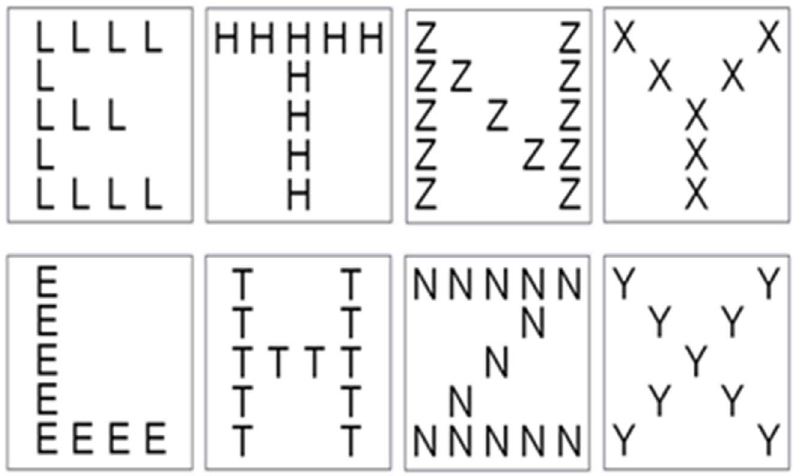
Figure 1. Stimulus examples for global and local target letters E, T, N, and Y with irrelevant letters H, L, X, and Z.